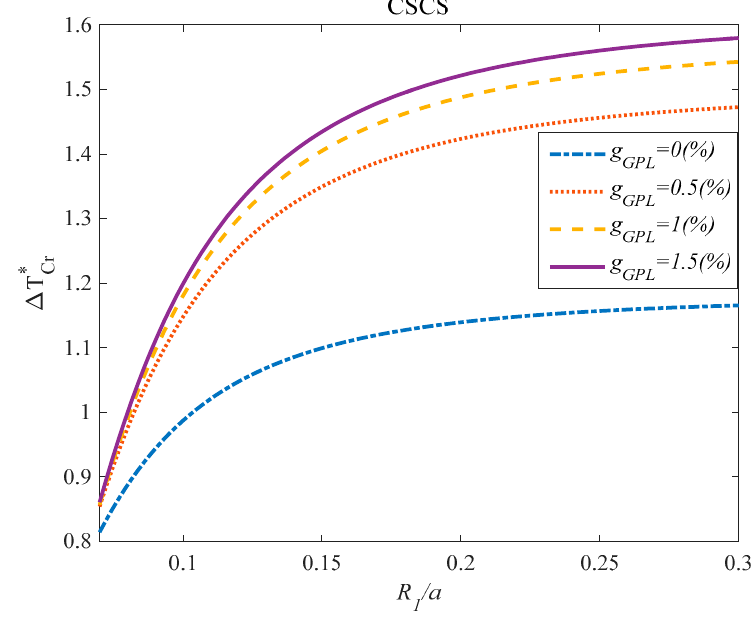
Figure 11. The effects of g_GPL and R_1/a on the critical temperature of a GPLRC panel for the CSSS boundary conditions (b/a = 4, h = a/10, NL = 10, R2 = 5b, μ = h/10, l = h/5, and GPL ‐ O).